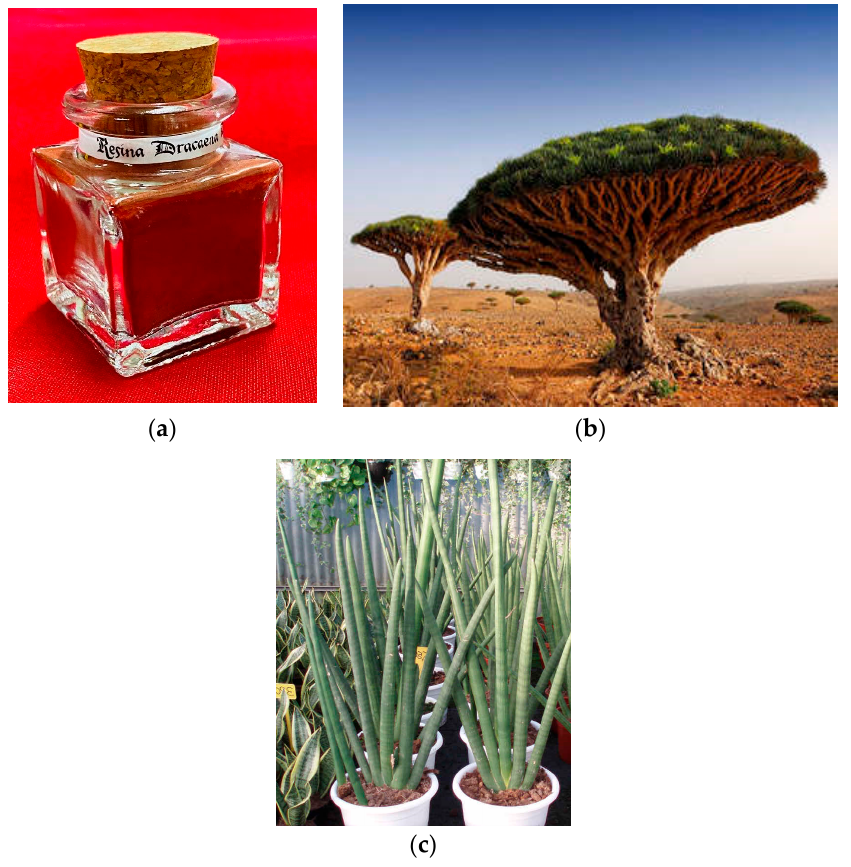
Figure 1. a ) Dragon’s blood; b ) Dracaena cinnabari Balf. f. (Socotra, Yemen); and c ) Sansevieria cylindrica Figure 1. ( a ) Dragon’s blood; ( b ) Dracaena cinnabari Balf. f. (Socotra, Yemen); and ( c ) Sansevieria cylindrica Bojer ex Hook. The images have been downloaded from the